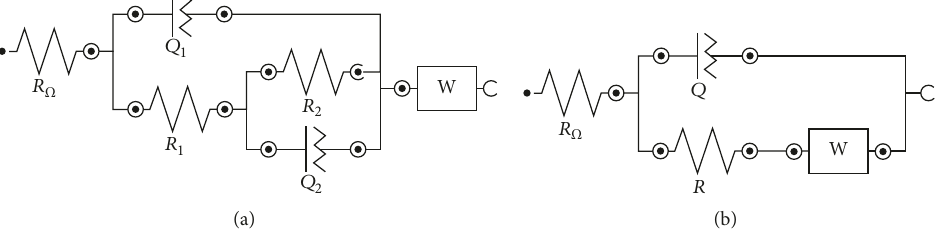
Figure 7: Equivalent electrical circuits proposed for fitting impedance spectra: (a) one based on a two-layer structure model; (b) a simpler circuit